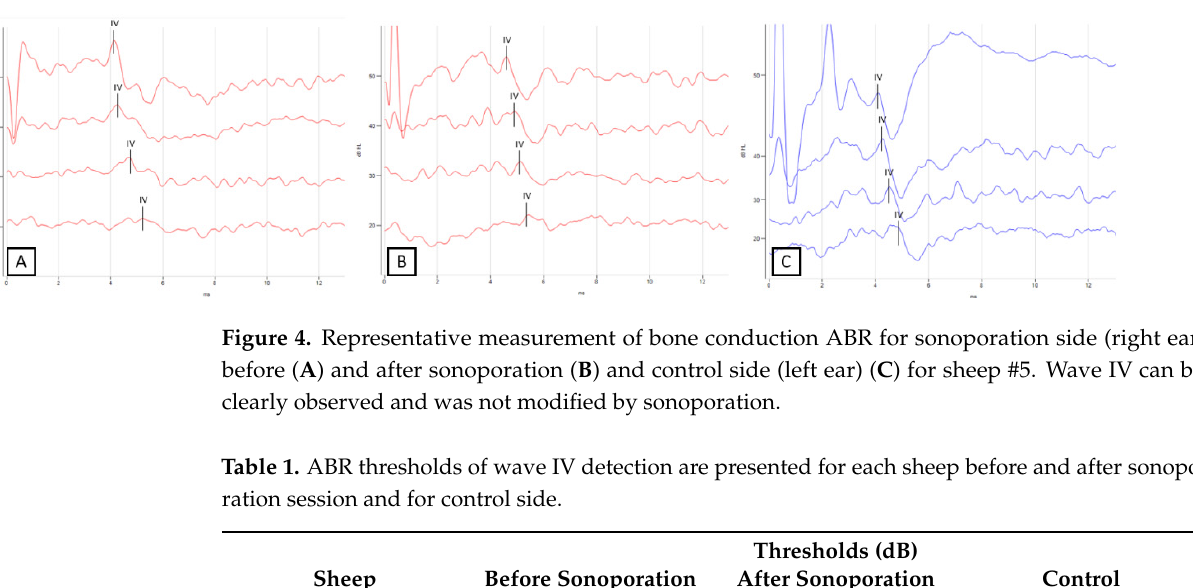
Table 1. ABR thresholds of wave IV detection are presented for each sheep before and after sono- poration session and for control side.